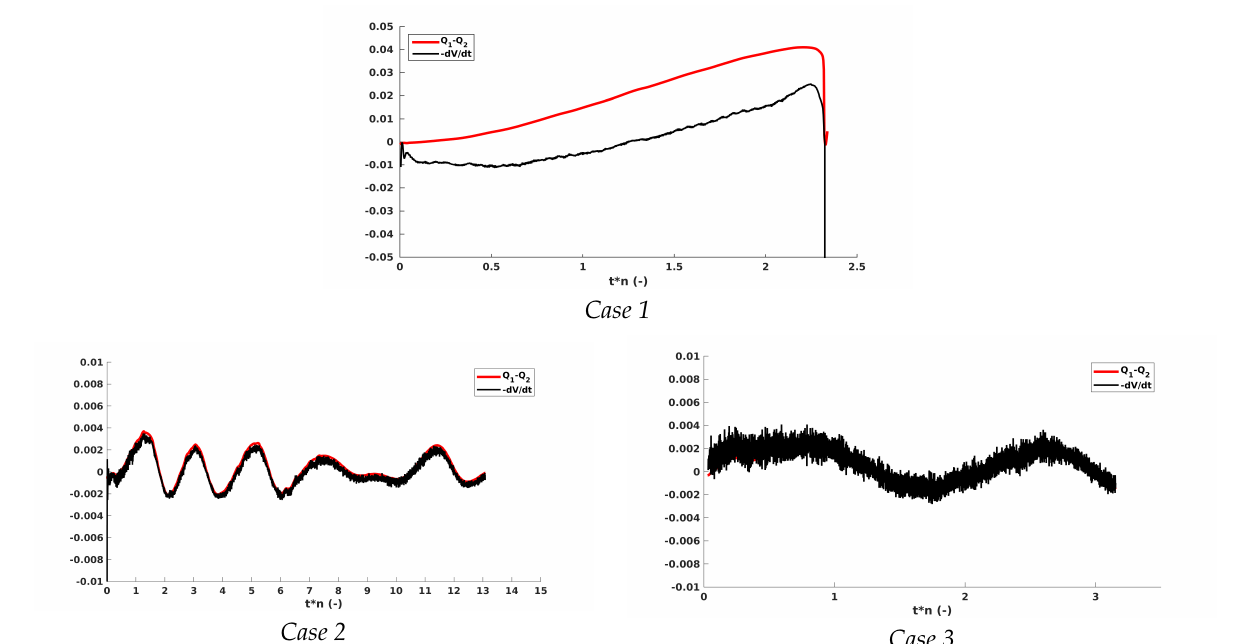
Figure 12. Time history of the left- and right- hand terms of Equation (2) for each